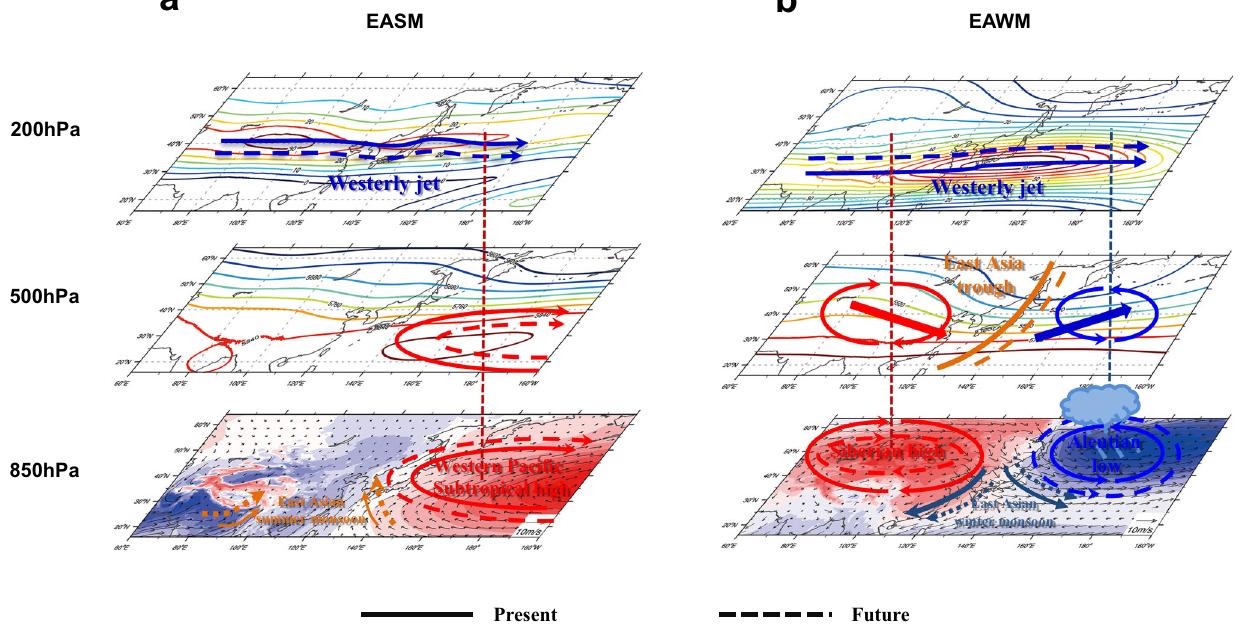
Fig. 2 Schematic diagram of the future changes of the East Asian monsoon circulations at GW1.5 and GW2. a For the East Asian summer monsoon (EASM) and b for the East Asian winter monsoon system (EAWM). The contour lines on each fi gure represent the present and future positions of climate systems (westerly jet, subtropical high, and East Asian trough) in the upper (top), middle (mid-row), and low-level (bottom) atmosphere. Table 1. Future changes of the East Asian summer monsoon system (EASM) and East Asian winter monsoon system (EAWM) at GW1.5 and GW2.